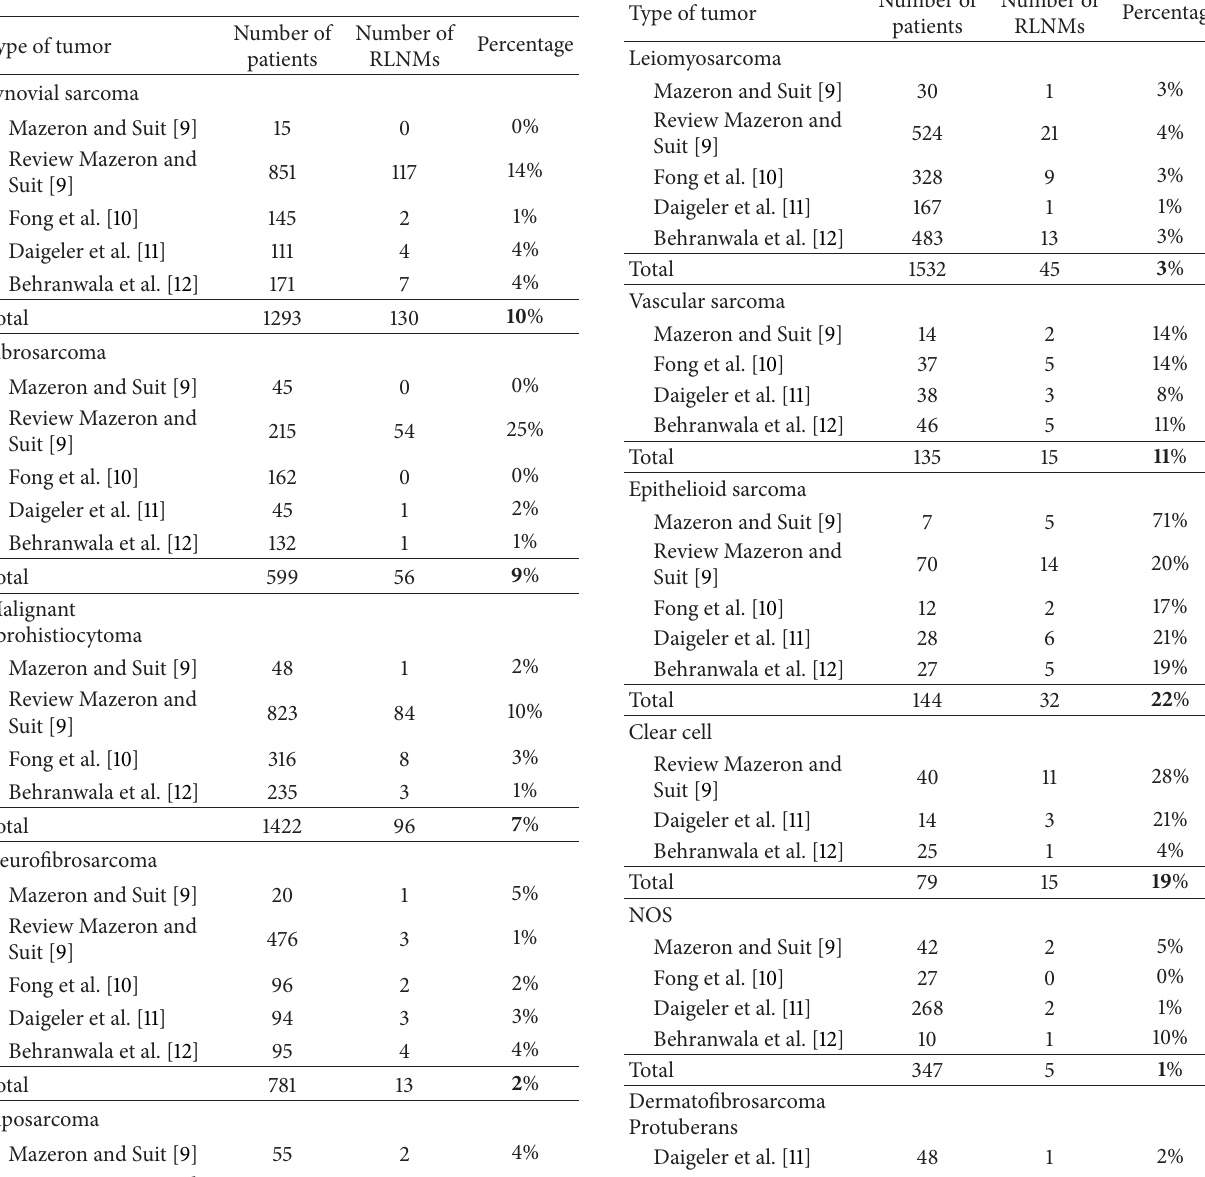
Table 1: Four studies on the number of patients with a STS who develop